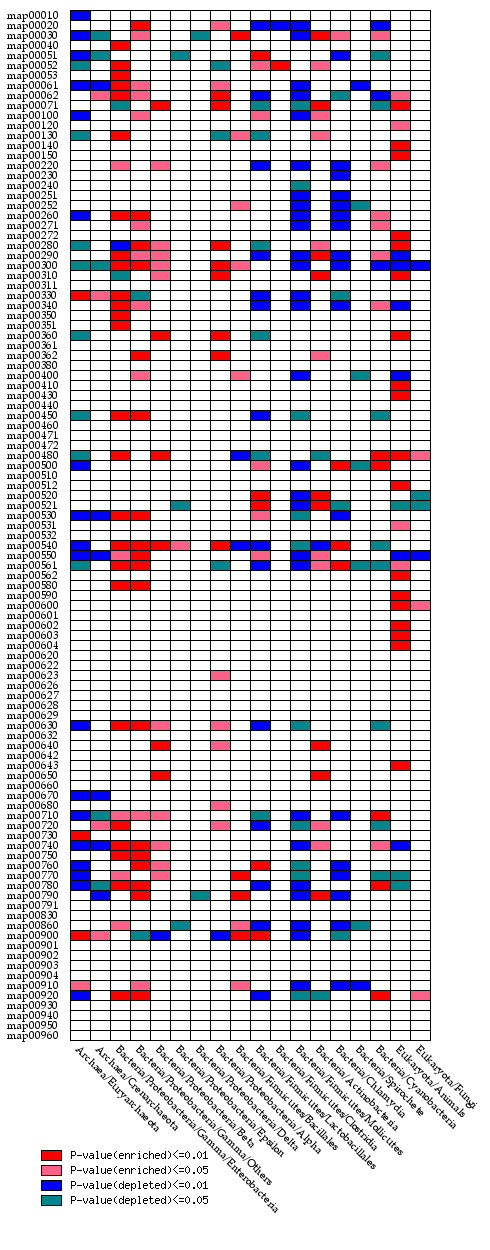
The distribution of P-values in differentphylogenetic categories. The Penriched-values and Pdepleted-values were calculated by using the equation 1 and equation 2 (see Methods), measuring whether a pathway specific subset was enriched in or depleted of organisms from a particular category (only P-values less than 0.05 are shown).